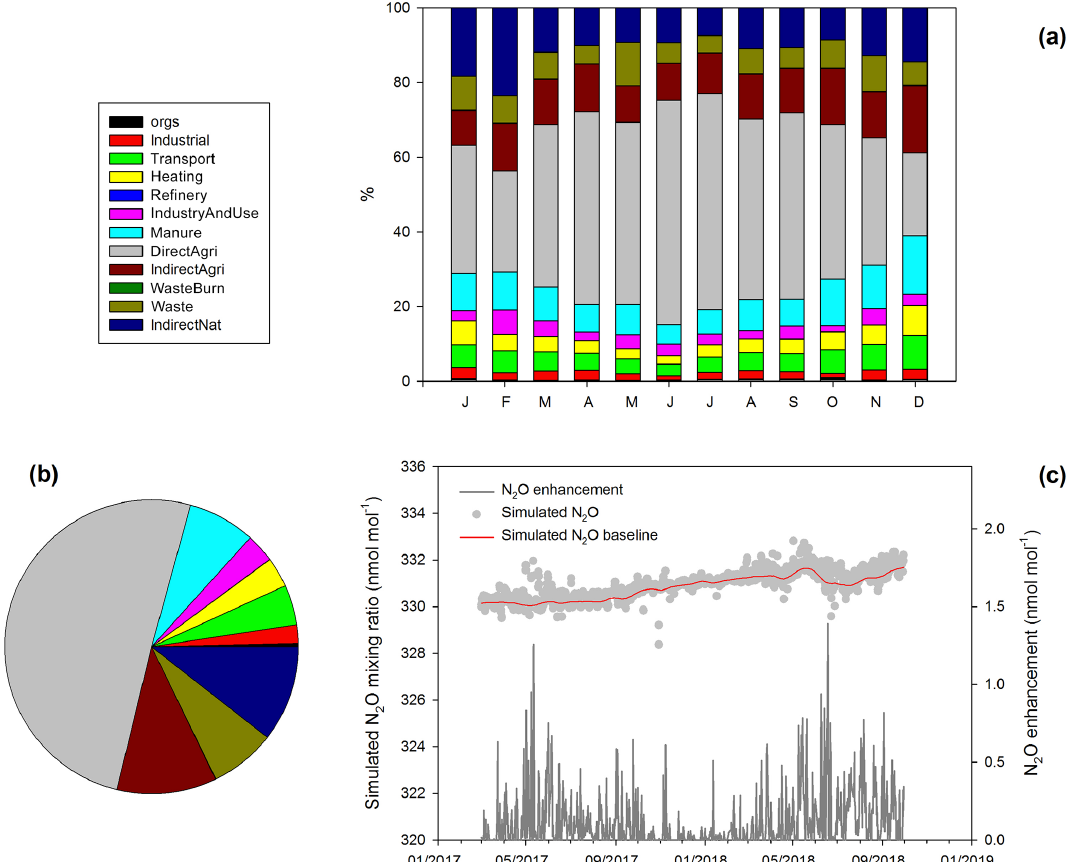
Figure 7. (a) Mean monthly stacked-bar plots of source contributions (%) to atmospheric N 2 O at Jungfraujoch derived from inversion modeling. (b) Overall contributions of N 2 O sources responsible for emission to Jungfraujoch. (c) Simulated 3-hourly N 2 O mixing ratios, N 2 O mixing ratio baseline and N 2 O enhancements in units of nanomole per mole (nmolmol − 1